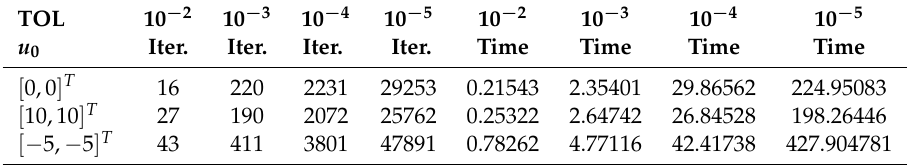
Algorithm 1. Numerical investigations regarding the fourth example is shown in Table 4. Table 4. Numerical behaviour of Algorithm 1 using different starting points for Example 4.